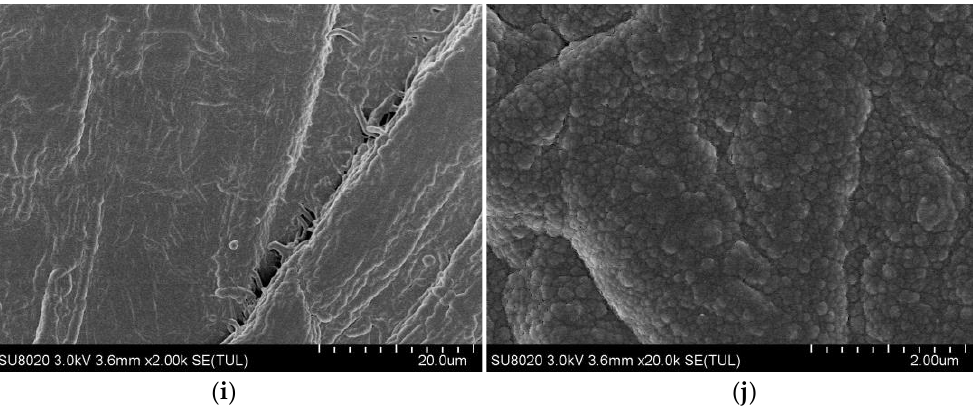
Figure 4. Scanning electron microscopy (SEM) images of the untreated insulating pressboard surface at 2k× magnification ( a ) and at 20k× magnification ( b ); surface of sample Z10-A30-P20 at 2k× magnification ( c ) and at 20k× magnification ( d ); surface of sample Z10-A30-P30 at 2k× magnification ( e ) and at 20k× magnification ( f ); surface of sample Z10-A60-P20 at 2k× magnification ( g ) and at 20k× magnification ( h ); and surface of sample Z10-A60-P30 at 2k× magnification ( i ) and at 20k× magnification ( j ).